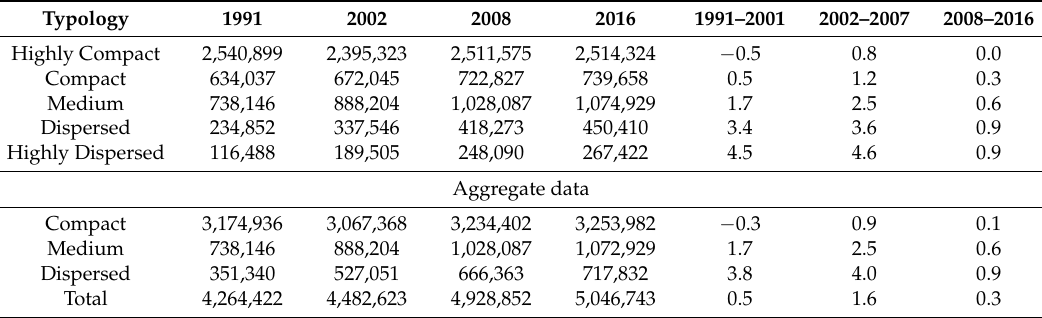
Table 2. Population evolution (1991–2016) in BMR municipalities by